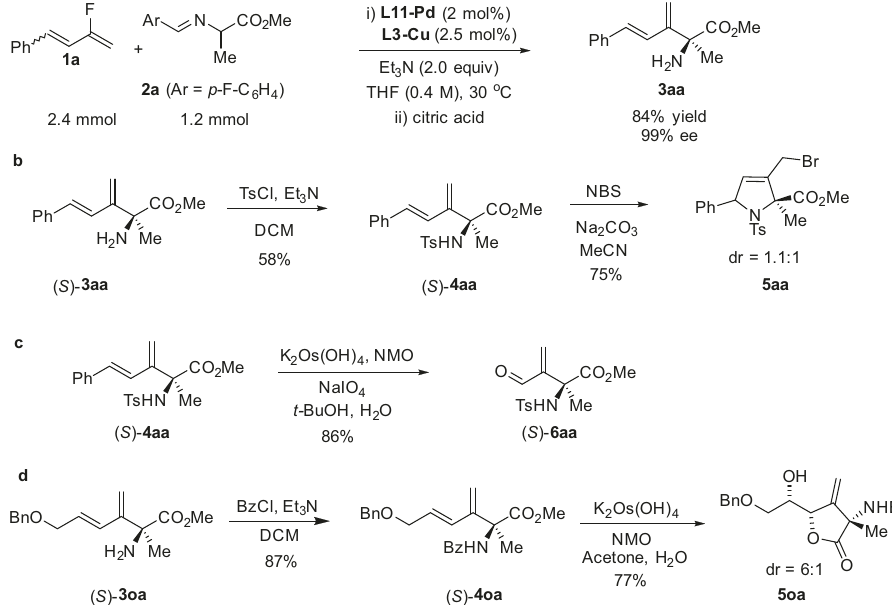
Fig. 4 Synthetic application. a Scale-up reaction at lower catalyst loading. b Intramolecular bromoamination reaction. c Selective cleavage of the internal alkene. d Dihydroxylation/lactonization